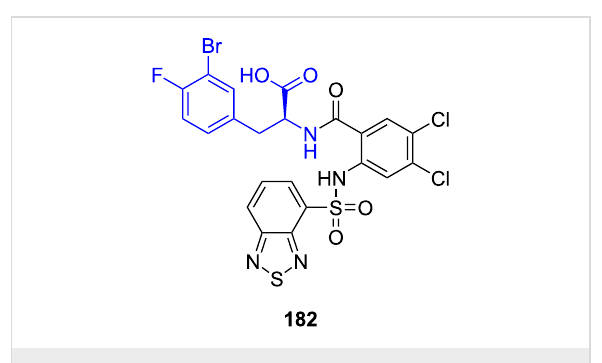
Figure 5: Dual CCK1/CCK2 antagonist 182 .